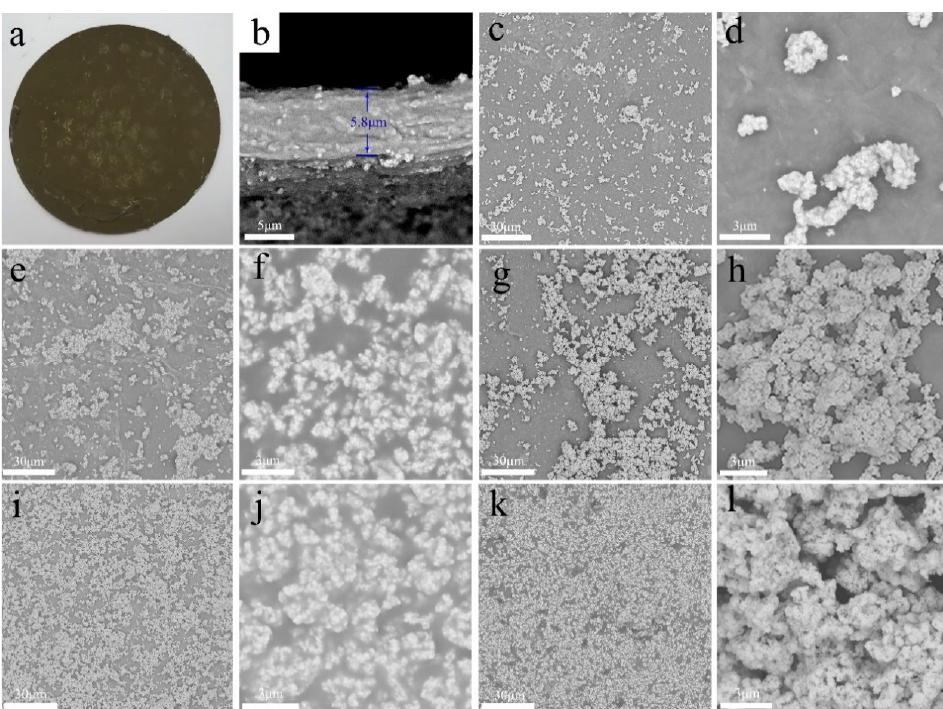
Figure 4. ( a ) Digital photograph and ( b ) cross section morphologies of the ANF@Ag nanocomposite film; surface morphologies of ( c – l ) the ANF@Ag nanocomposite films with different Ag content: ( c , d ) 6.9 vol%; ( e , f ) 13.8 vol%; ( g , h ) 20.7 vol%; ( i , j ) 27.6 vol% and ( k , l ) 34.6 vol%.